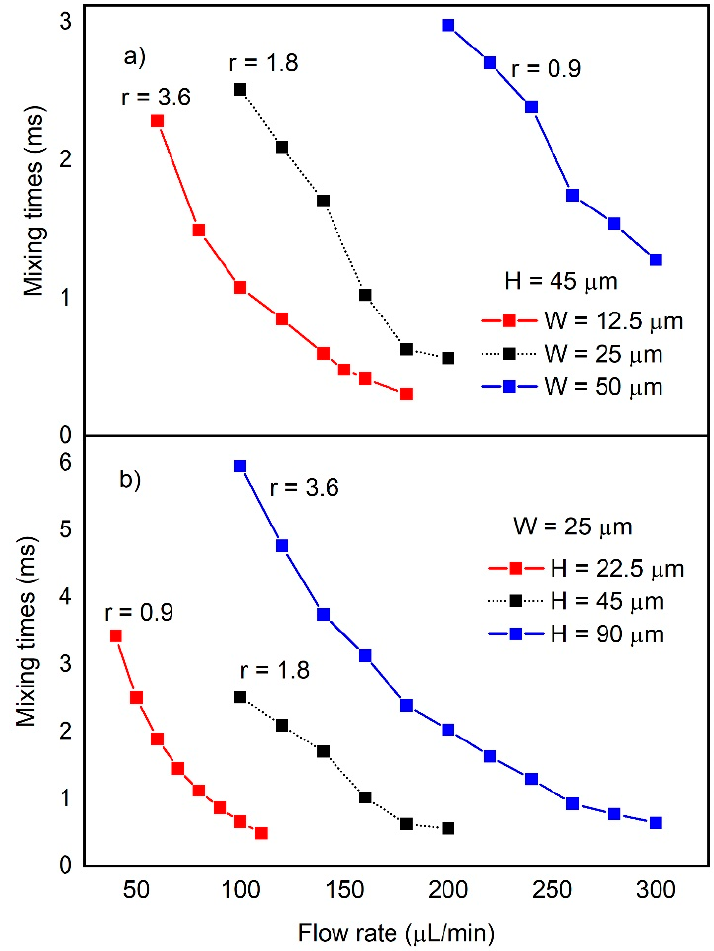
Figure 8. Minimum achievable mixing time (in milliseconds) using a serpentine micromixer for ( a ) H = 45 µm, W = 12.5, 25, and 50 µm, and ( b ) W = 25 µm, H = 22.5, 45, and 90 µm as a function of flow rate. The aspect results matching the height-to-width ratio used experimentally (represented in ( a ) and ( b ) by a dotted line) has an aspect ratio of r = H/W = 1.8 and is included for comparison.